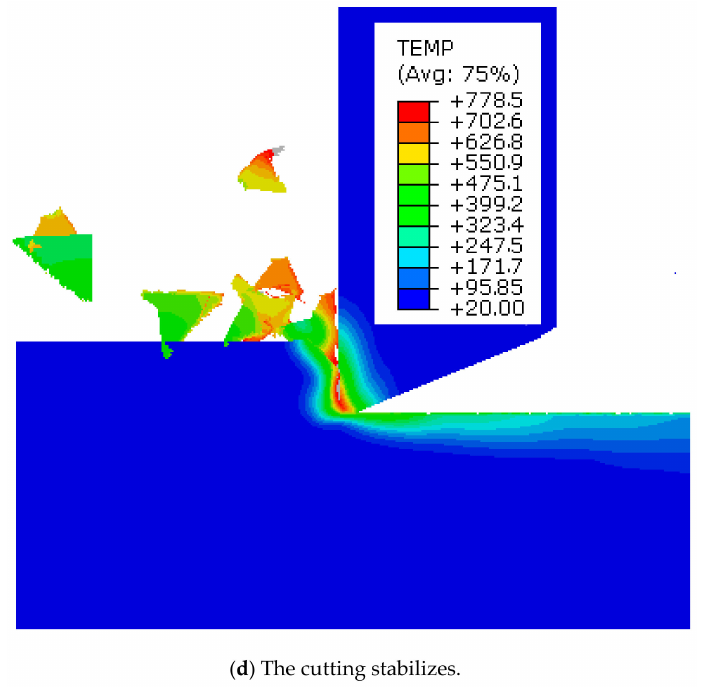
Figure 9. Temperature distribution in the cutting process of cast iron.